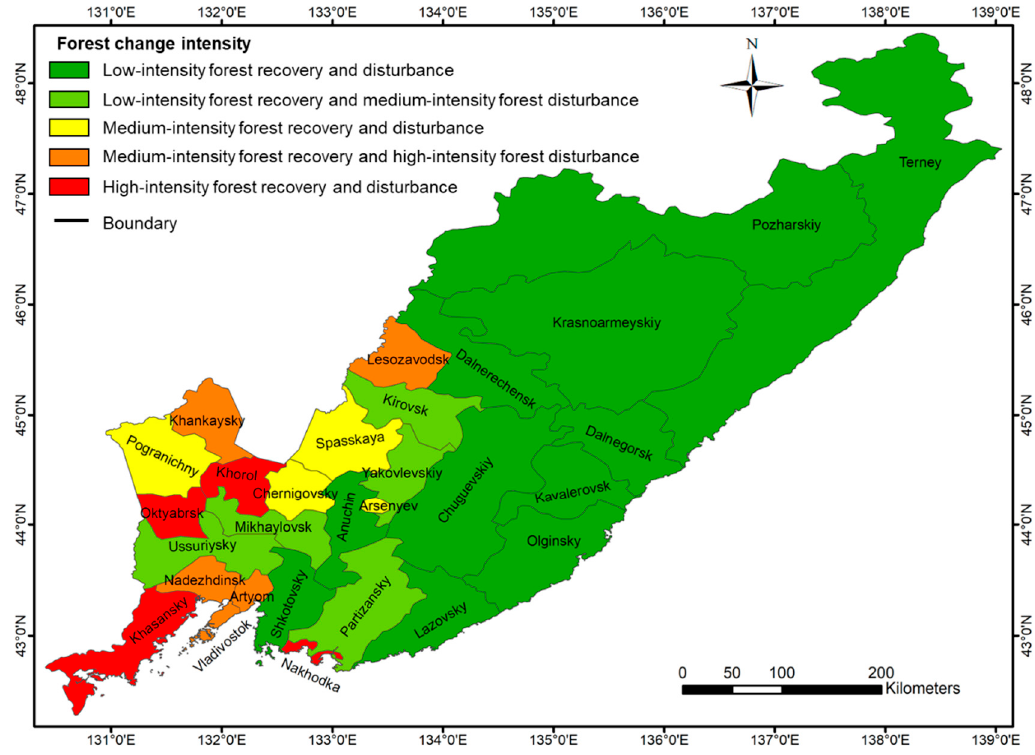
Figure 8. Forest change intensity in each administrative region of the study area. Low–intensity forest recovery and disturbance means that the cumulative change area accounts for less than 10% of the regional forest area in 1998. Medium–intensity forest recovery and forest disturbance means that the cumulative change area accounts for between 10% and 30% of the regional forest area in 1998. High–intensity forest recovery and disturbance means that the cumulative change area accounts for more than 30% of the regional forest area in 1998.